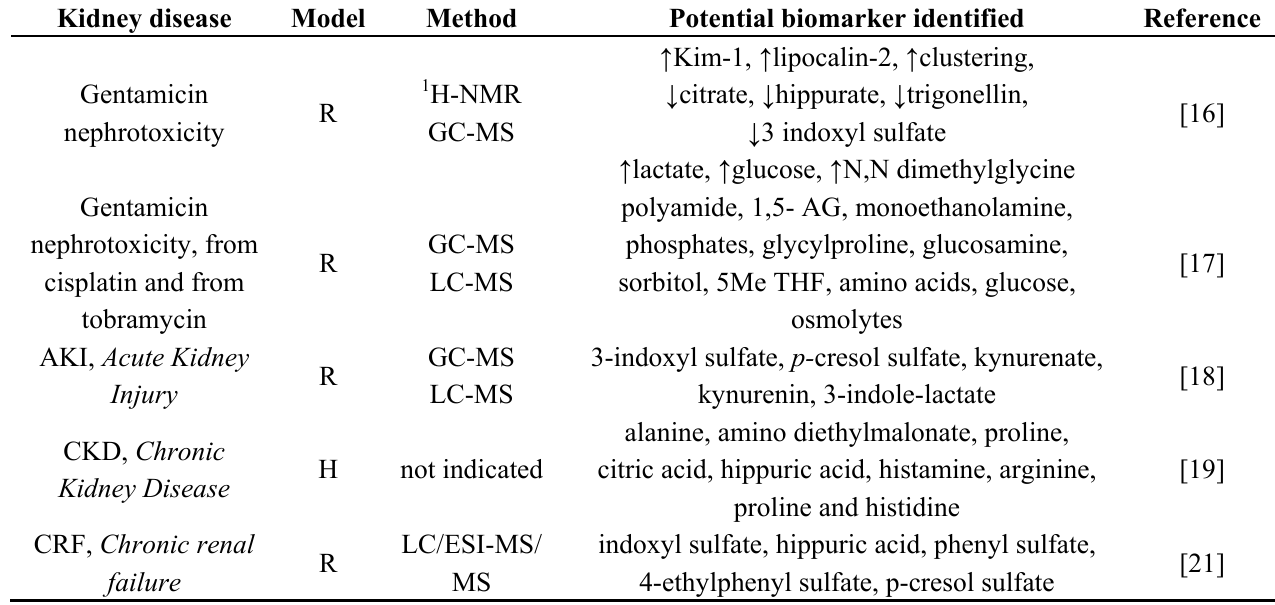
Table 1. Main studies on metabolomics in